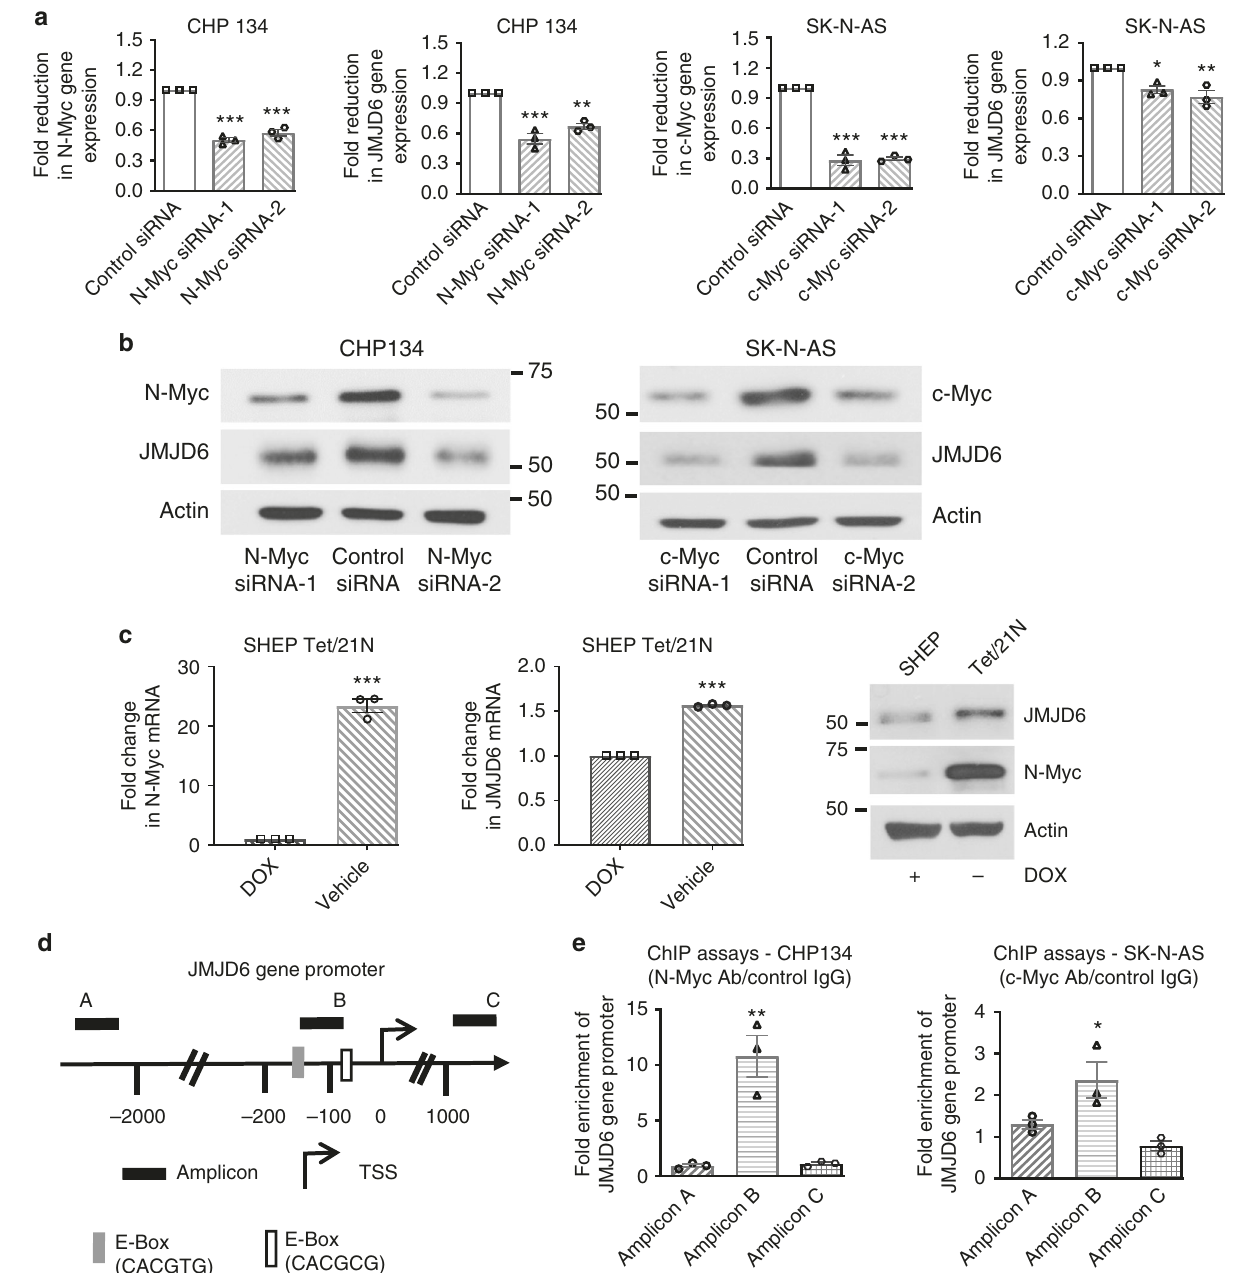
Fig. 2 N-Myc and c-Myc upregulate JMJD6 expression by binding to the JMJD6 promoter. a , b CHP134 cells were transfected with control siRNA, N-Myc siRNA-1 or N-Myc siRNA-2, and SK-N-AS cells were transfected with control siRNA, c-Myc siRNA-1, or c-Myc siRNA-2. Forty-eight hours later, RNA and protein were extracted for RT-PCR ( a ) and immunoblot ( b ) analyses. Error bars represent normalized standard errors from three independent experiments (** p < 0.01, *** p < 0.001, one-way ANOVA). c SHEP Tet/21N cells were treated with DOX (2 µ g/ml) or vehicle control for 48 h. RT-PCR and immunoblot analyses were conducted. Error bars represent normalized standard errors from three independent experiments (*** p < 0.001, two-tailed unpaired Student ’ s t test). d Schematic representation of the JMJD6 gene promoter. TSS indicates transcription start site. Amplicons A, B, and C represented the sites for ChIP PCR primers. e ChIP assays were performed with a control IgG, anti-N-Myc or anti-c-Myc antibody (Ab), followed by PCR with primers targeting a remote negative control region (amplicon A), the E-box region (amplicon B), or the exon 2 region (amplicon C) of the JMJD6 gene in CHP134 and SK-N-AS cells. Fold enrichment of the JMJD6 gene region was calculated as the difference in cycle thresholds obtained with the anti-N-Myc or anti-c- Myc Ab compared with the control IgG, relative to input. Error bars represent normalized standard errors from three independent experiments (* p < 0.05, ** p < 0.01, two-tailed unpaired Student ’ s t test). Source data are provided as a Source Data fi